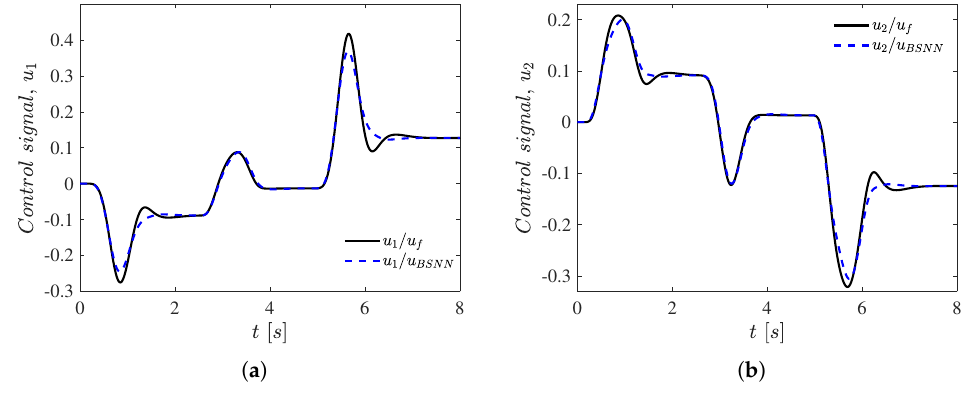
Figure 16. Control signals: ( a ) u 1 ; ( b ) u 2 .